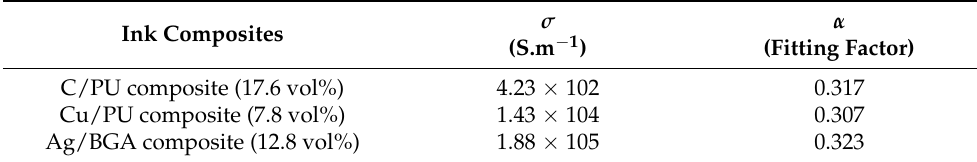
Table 8. Measured electrical conductivity ( σ ) and fitting factor ( α ).